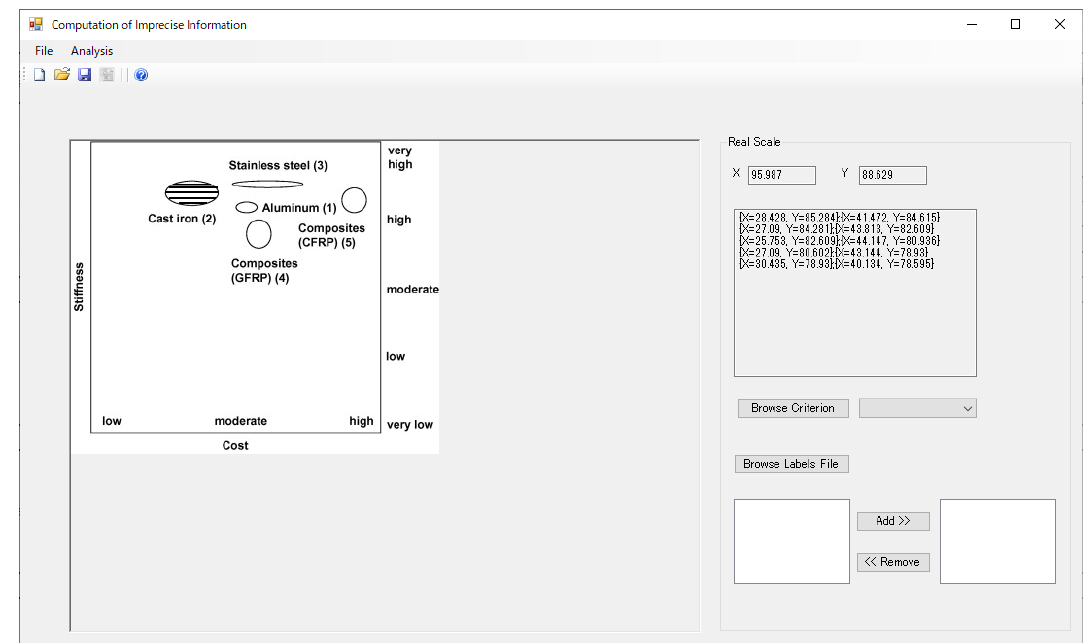
Figure 6. An example of extracting intervals from an alternative.